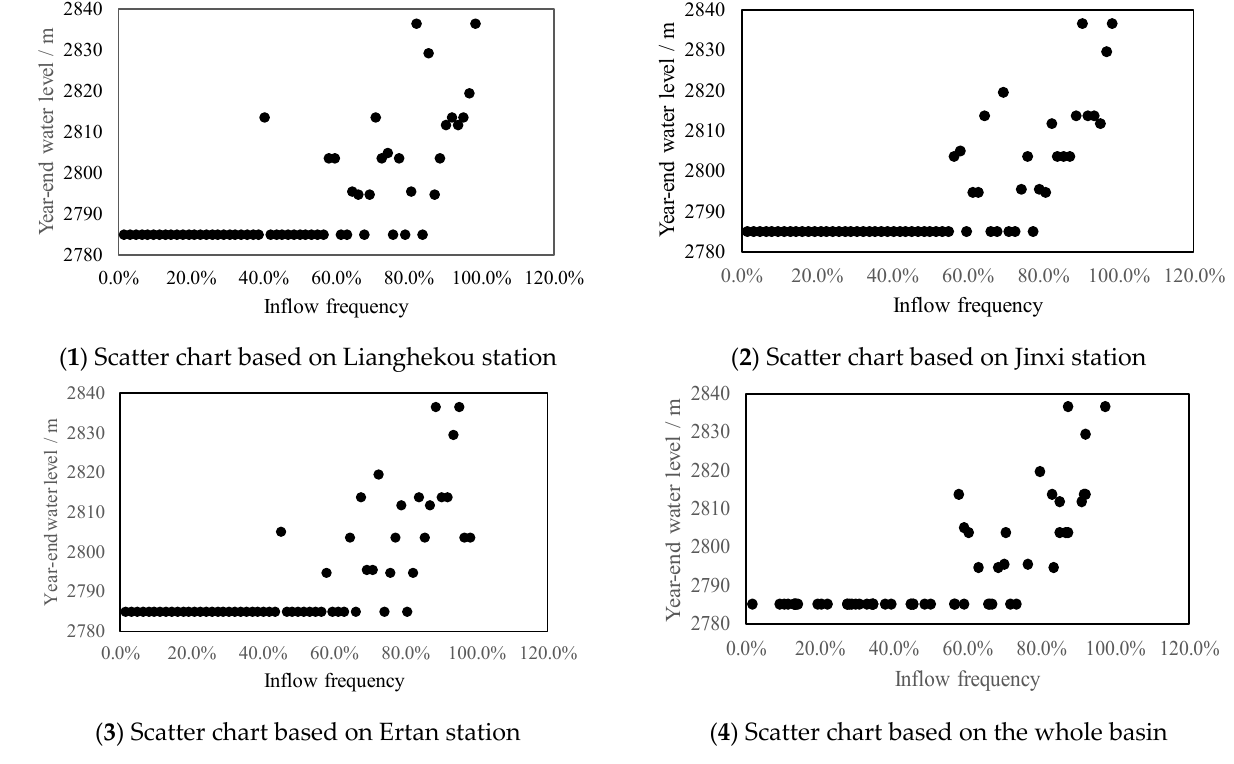
Figure 7. Scatter charts of inflow frequency and yearly drawdown level of Lianghekou reservoir with different incoming flow frequencies as references.